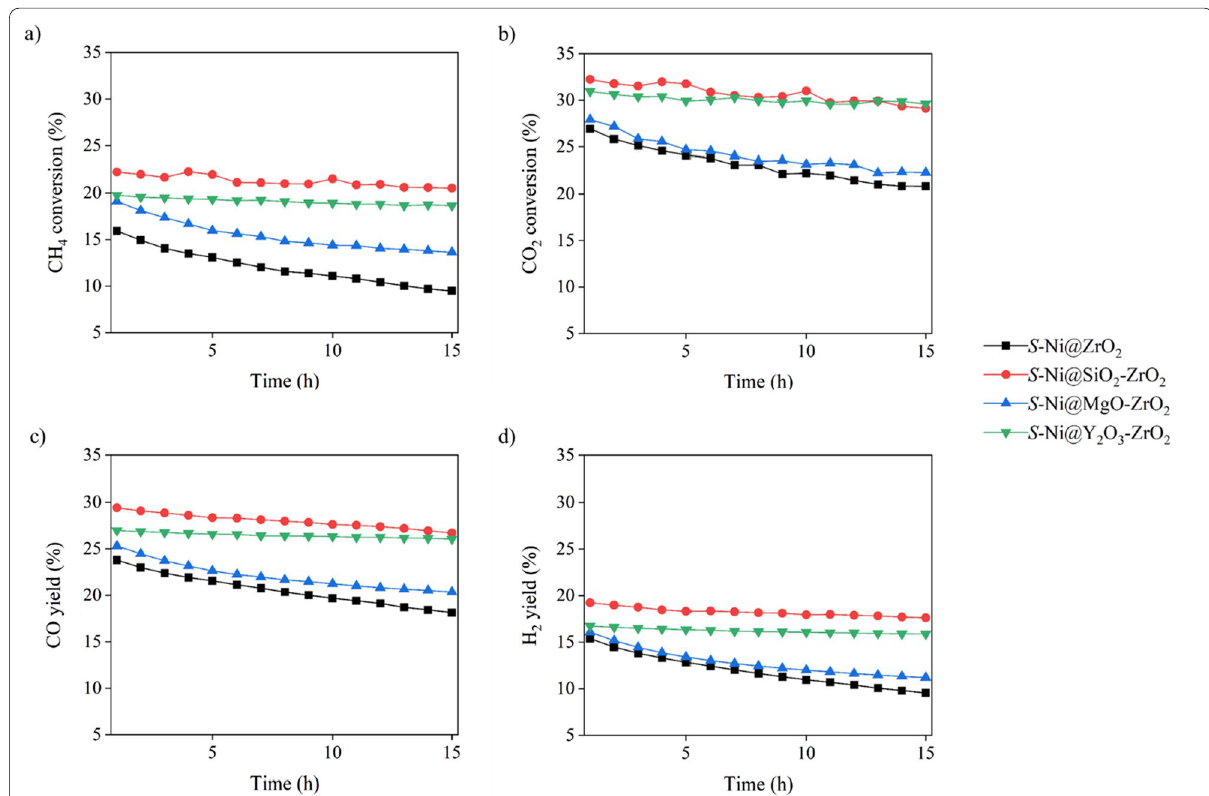
Fig. 6 CH 4 and CO 2 conversions; CO and H 2 yields of DRM reactions catalyzed by S -Ni@ZrO 2 , S -Ni@SiO 2 -ZrO 2 , S -Ni@MgO- ZrO 2 , and S -Ni@Y 2 O 3 -ZrO